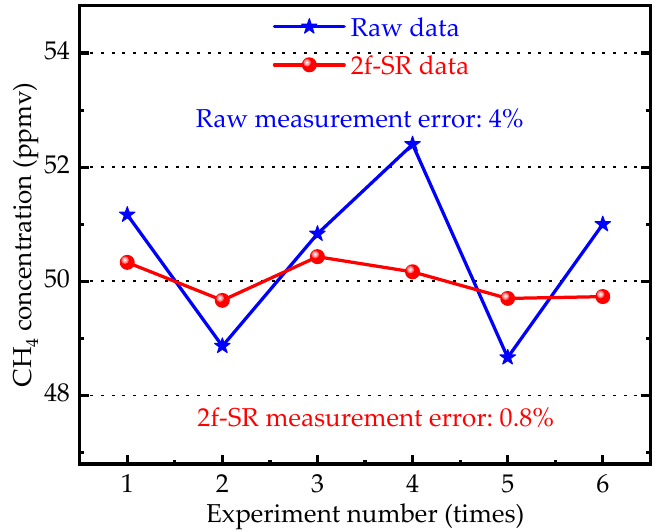
Figure 8. Comparison of raw data and 2f-SR data of overlapping absorption lines.